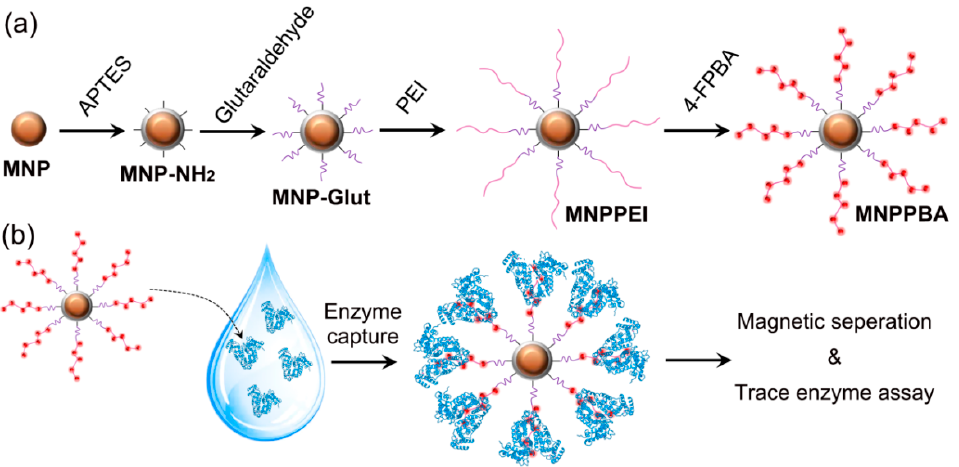
Figure 1. Schematic illustration of MNPPBA synthesis ( a ) and its application in trace enzyme assay ( b ). assay ( b